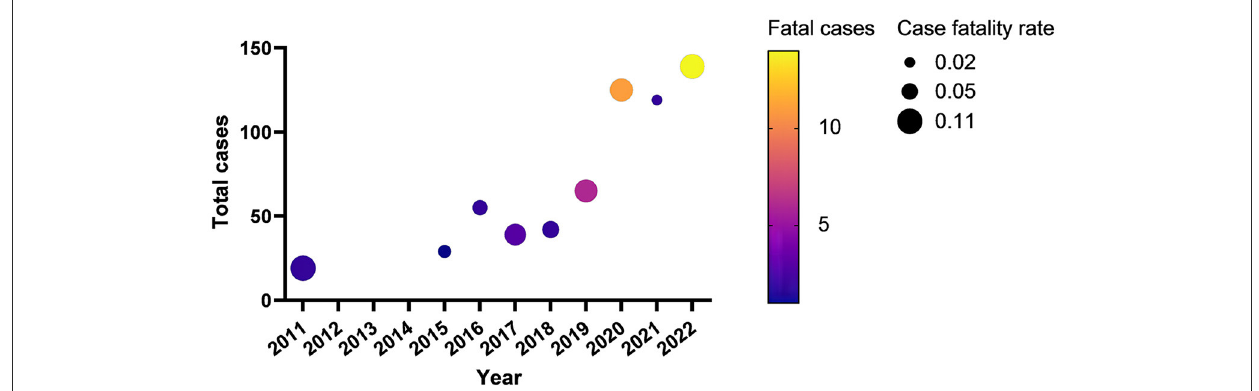
FIGURE1 The fatal cases and the case fatality rate from 2011 to 2022.